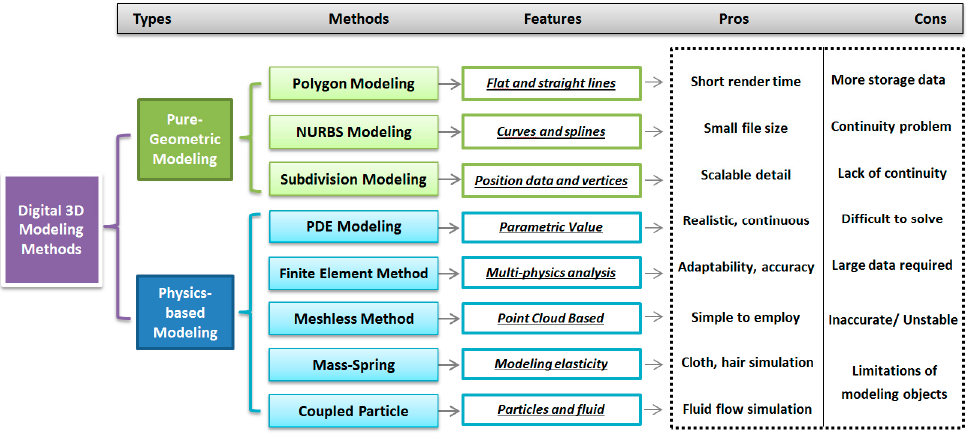
Figure 1. Comparison of different digital 3D modeling methods.